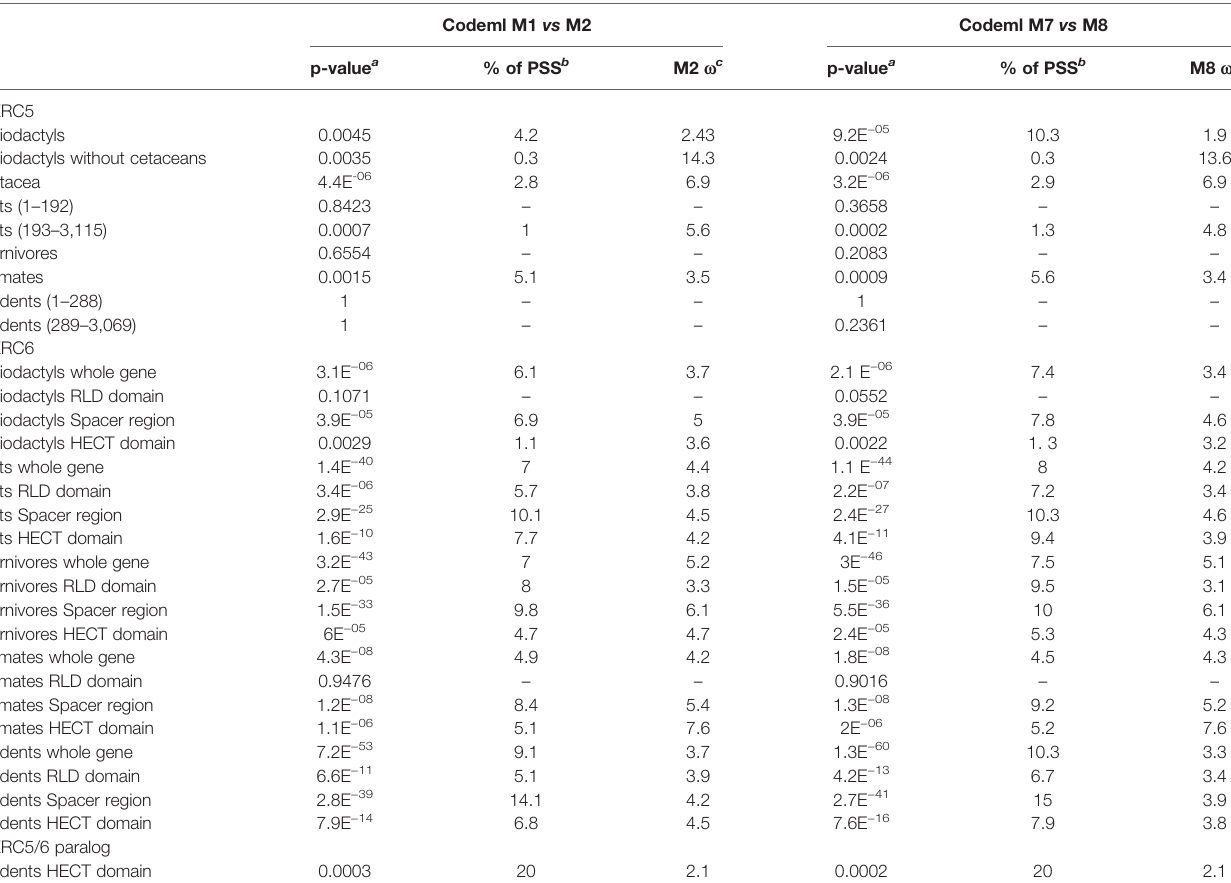
TABLE 1 | Positive selection analyses of mammalian HERC5 and HERC6 genes.